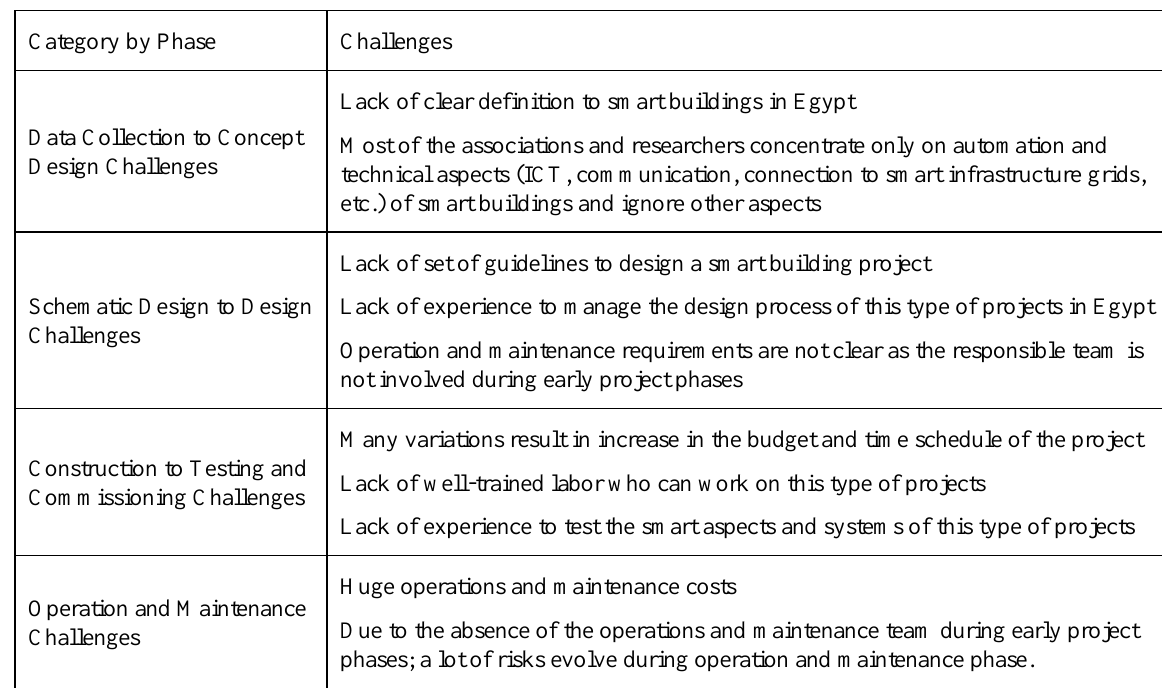
Table 4.Challenges of SBP in Egypt ; Source: Authors based on Literature Sources and Analysis of Case